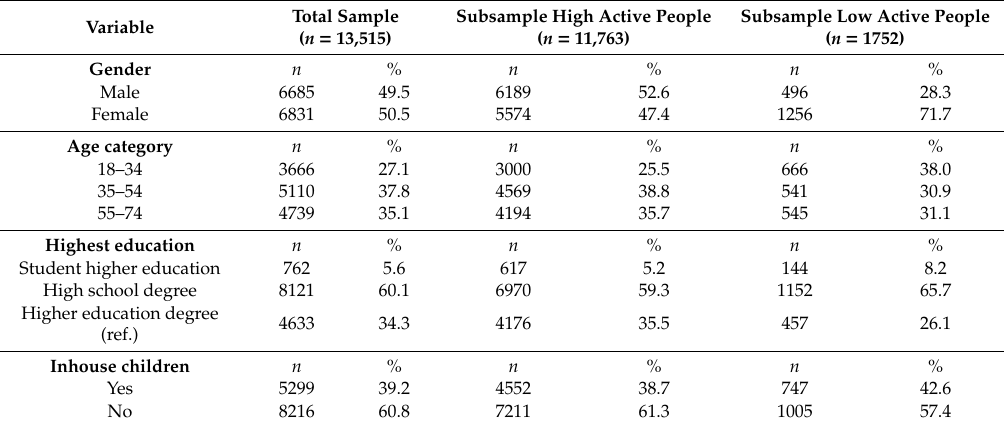
Table 1. Participant demographics ( n =